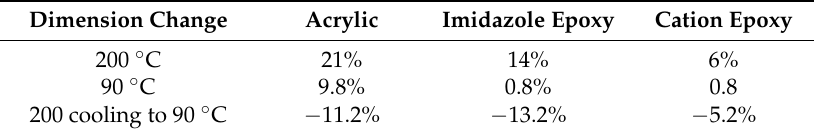
Table 2. Shrinkage percentages of typical adhesives films during cooling.